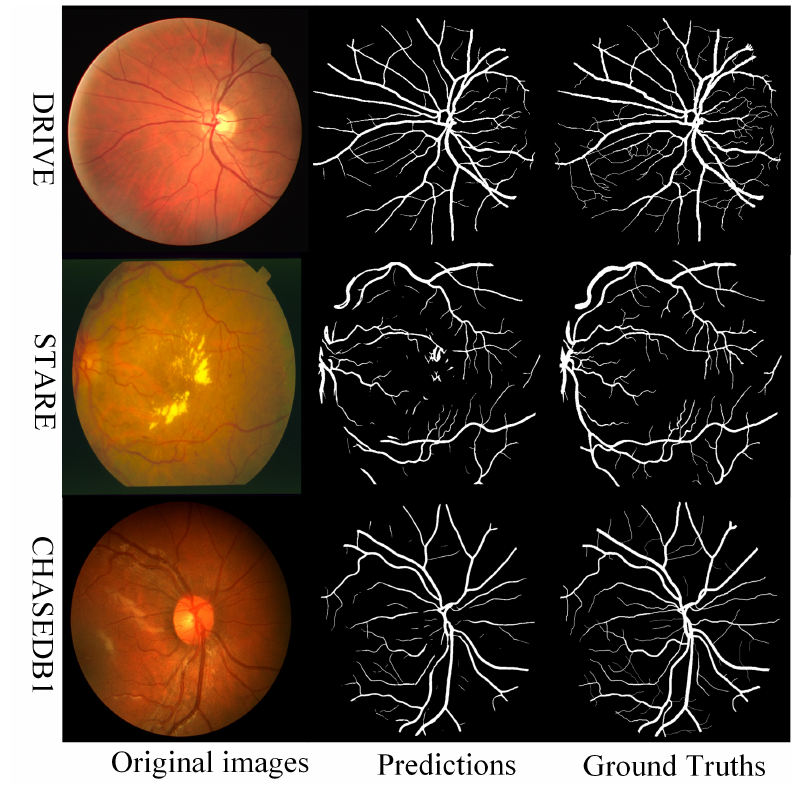
Figure 3. Bad segmentation examples on three databases.